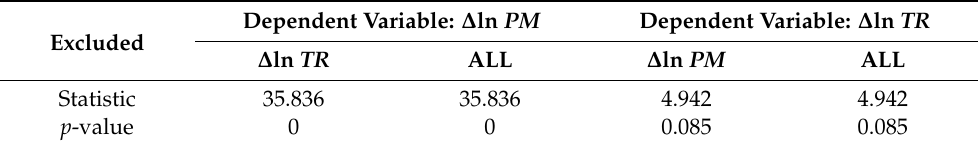
Table 5. The results of the Granger causality test.